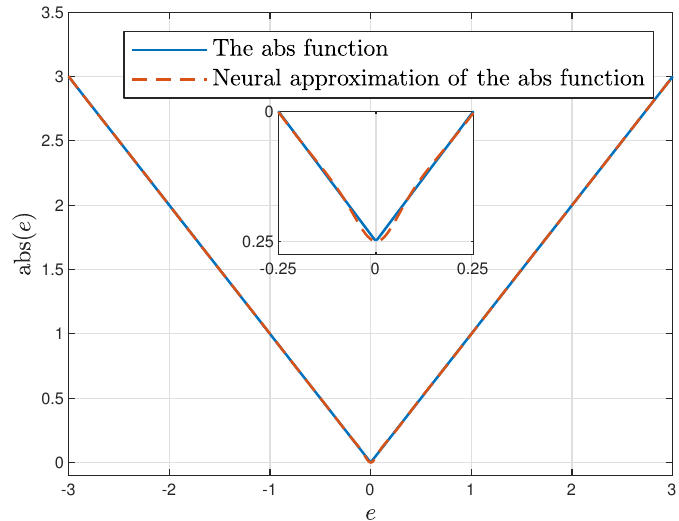
Figure 1. The absolute value function vs. its neural